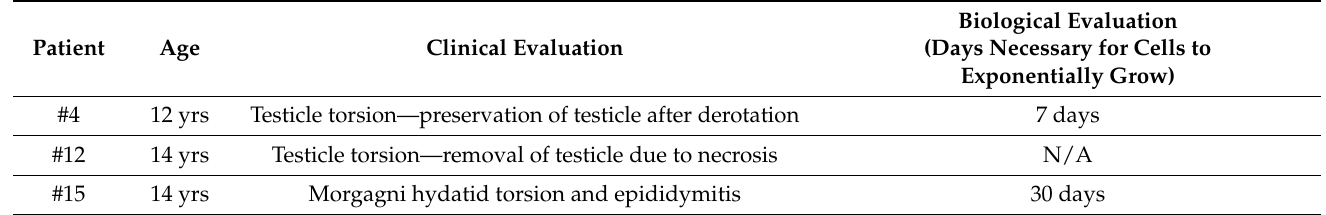
Figure 1. Gubernacular tissue in vitro culture. ( A ) Schematic representation of the protocol that we optimized to isolate and in vitro cultivate gubernacular cells. Scale bar: 100 µ m. ( B ) Representative, bright field images of gubernacular cells of patients #4 and #15. White arrows indicate cells with fibroblast features and black arrows indicate cells with smooth muscle features. Scale bar: 25 µ m. Table 1. Clinical and biological evaluations of the analyzed patients and patient derived cells.